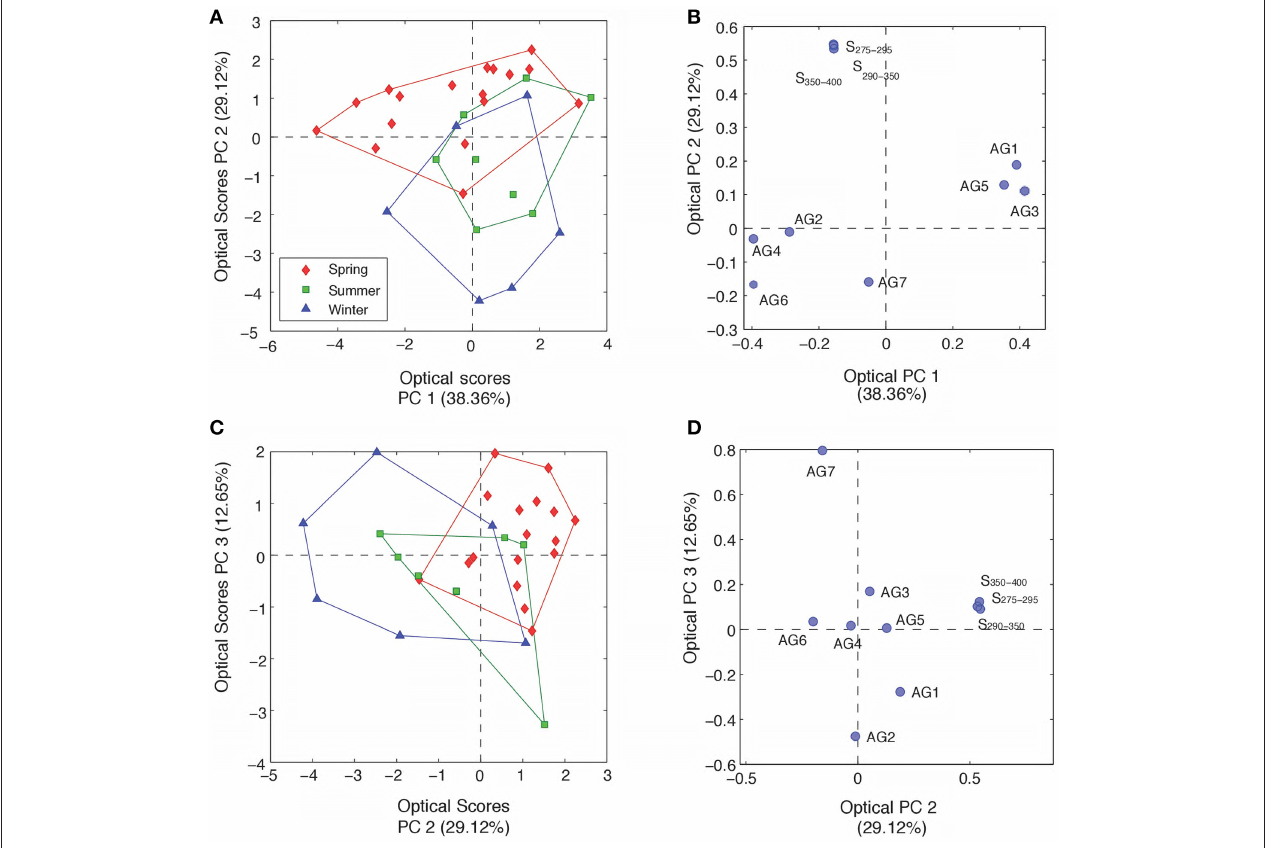
FIGURE 4 | (A) Principle component scores across PC1opt and PC2opt for all optical samples labeled by season. (B) PC scores of each optical parameter across PC1opt and PC2opt. (C) Principle component scores across PC2opt and PC3opt for all optical samples labeled by season. (D) PC scores of each optical parameter across PC2opt and PC3opt. FI and SUVA 254 values were not included in the final optical PCA, see text for details.